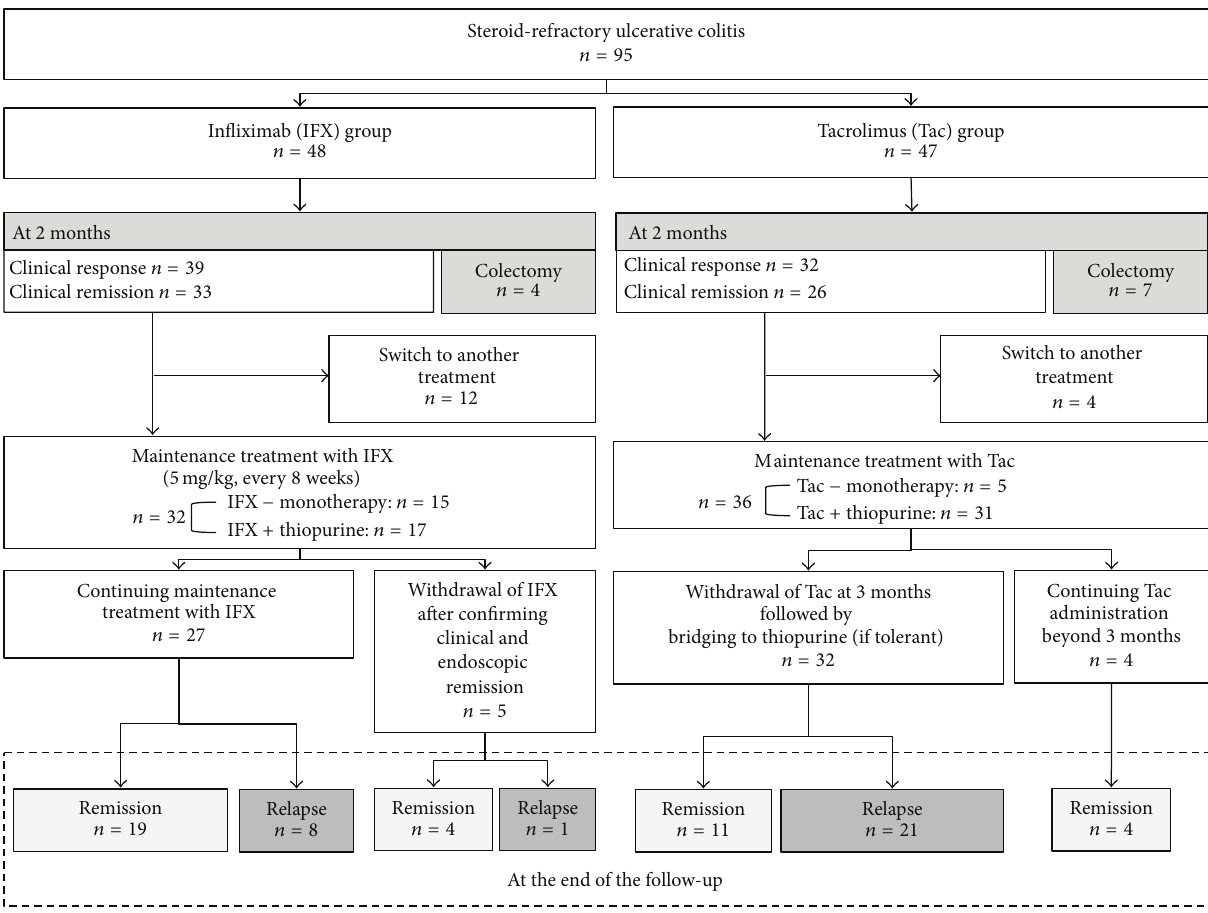
Figure 1: Flowchart of treatment outcomes in the infliximab group (𝑛 = 48) and tacrolimus group (𝑛 = 47) .